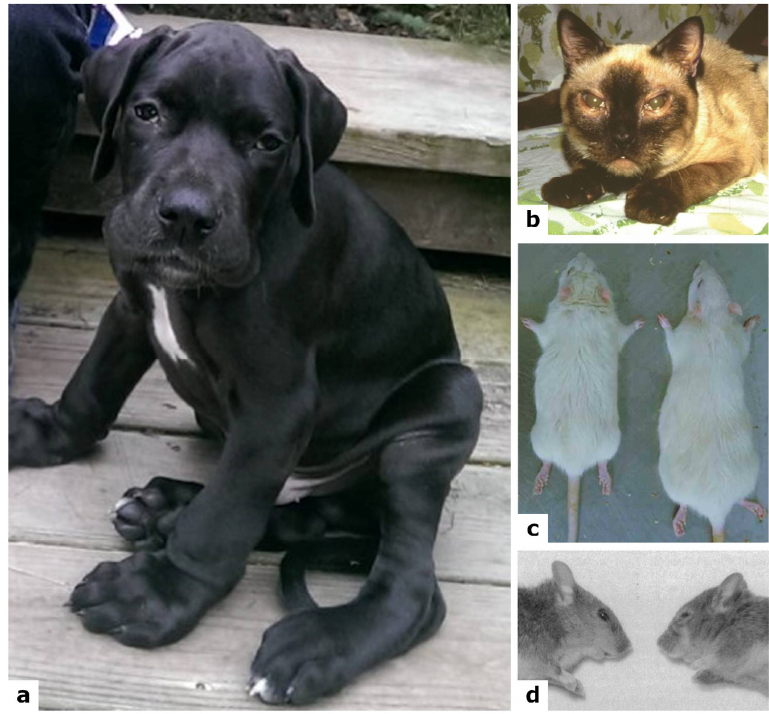
Figure 4. Photographs of some MPS VI animal models. ( a ) Great Dane spontaneous mutant at 4 months of age (reproduced with permission from [124]). ( b ) Siamese cat spontaneous mutant (reproduced with permission from [125]). ( c ) Rat spontaneous model (on the left) compared with wild type (on the right) at 6 months of age (reproduced with permission from [126]). ( d ) Mouse knock-out model (on the right) compared with wild type (on the left) aged 15 months (reproduced with permission from